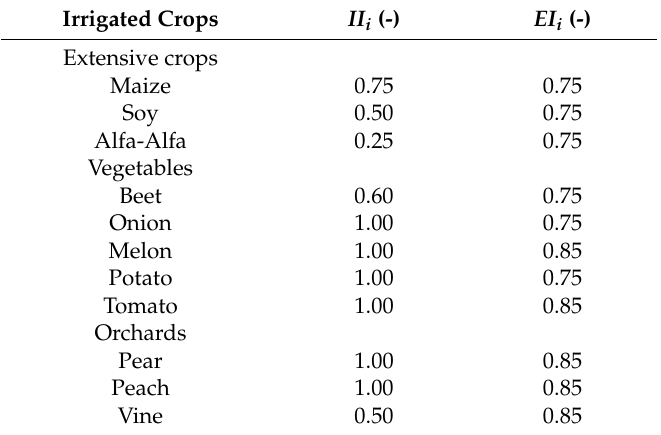
Table 2. The values of the coefficients intensity of irrigation (II) and efficiency of the irrigation method ( EI) for the irrigated crops served by PS and extended segment (ES). Irrigated Crops II i (-) EI i